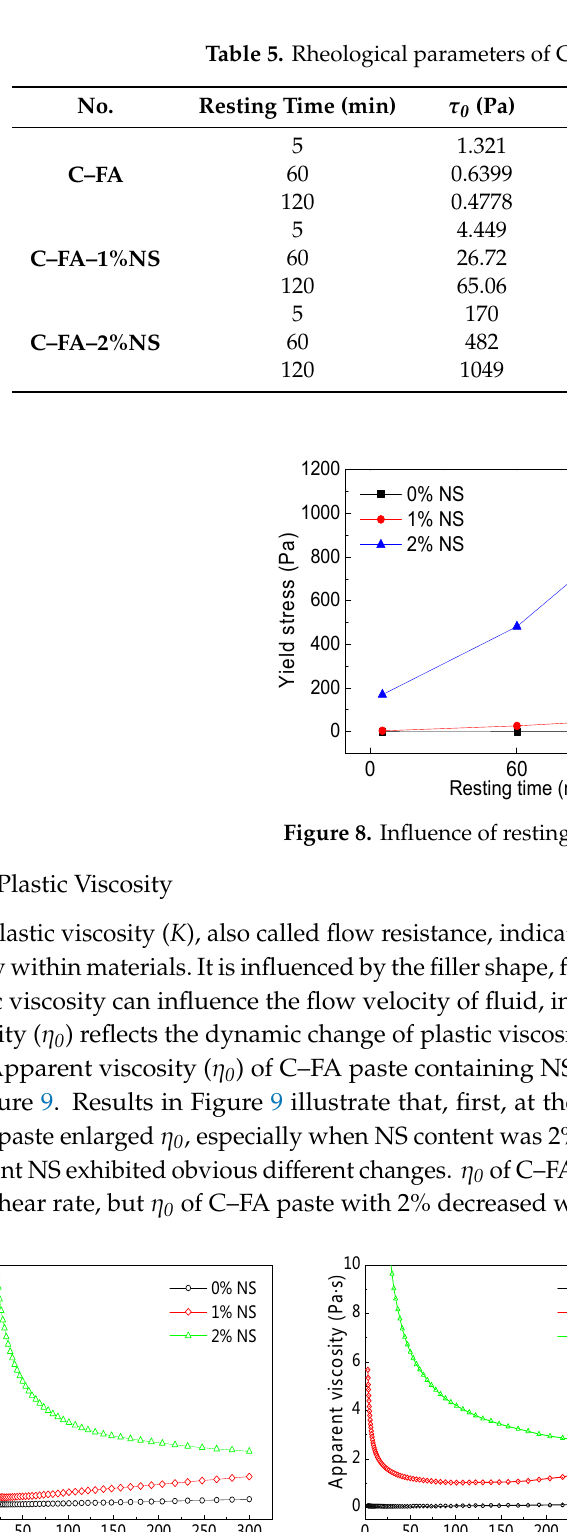
( c ) Figure 9. Apparent viscosity vs. shear rate under different NS content and resting time. ( a ) 5 min; ( b ) 60 min; ( c ) 120 min.